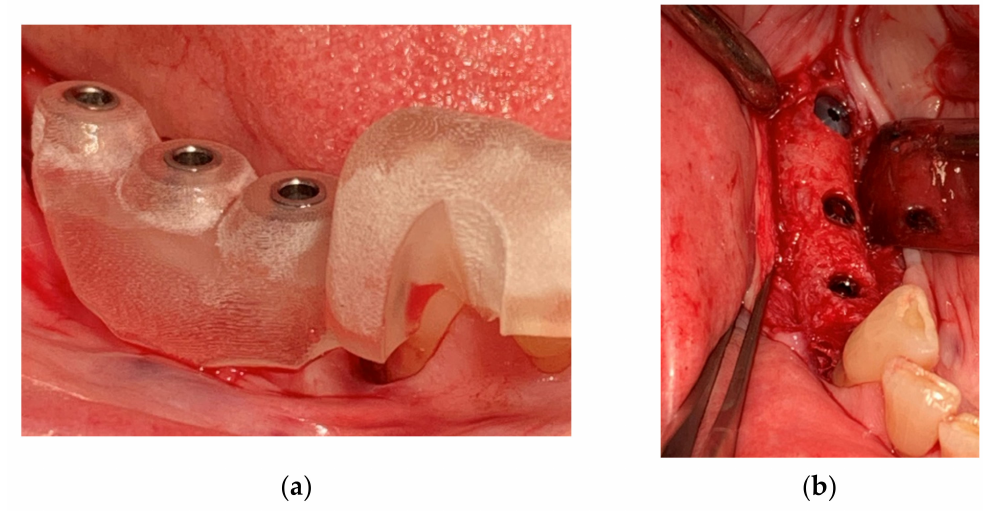
Figure 15. Drill guide ( a ) and implants in place ( b ).